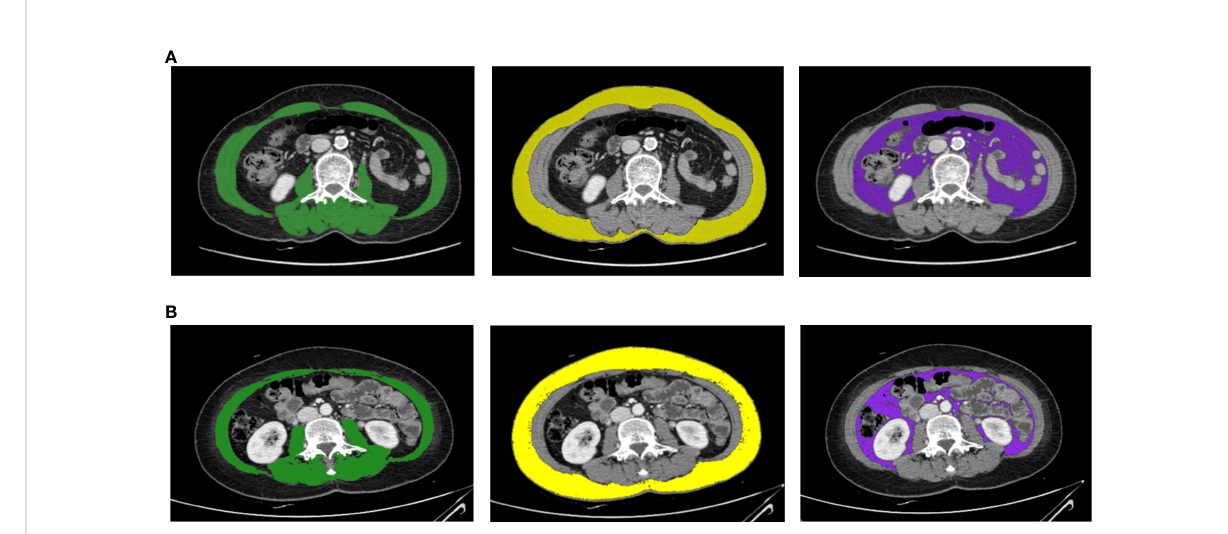
FIGURE 1 Body composition evaluation CT images for two breast cancer patients with the same BMI (23.37 kg/m 2 ) and weight (54.7 kg). These axial CT images of the third lumbar vertebral region show that two study participants with the same BMI can have different body compositions. Panel (A) is a CT image for a 69-year-old female, and panel (B) is a CT image for a 48-year-old female. The images illustrate the different proportions of skeletal muscle mass (green), subcutaneous fat area (yellow), and visceral fat area